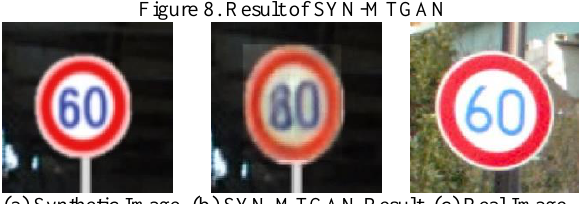
Figure 8. Result of SYN-MTGAN